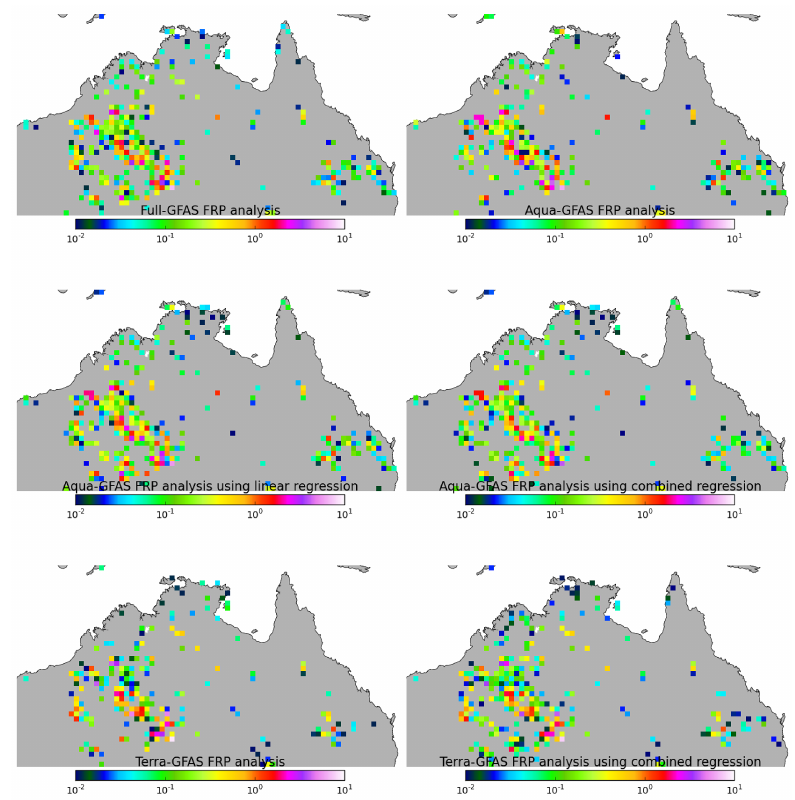
Figure 10. Daily FRP in mWm − 2 for Australia on 23/10/2012, given by Full-GFAS (top left), Aqua-GFAS (top right), Aqua-GFAS using linear regression (middle left) and non-linear regression (middle right), as well as Terra-GFAS (bottom left) and Terra-GFAS using non-linear regression (bottom right).